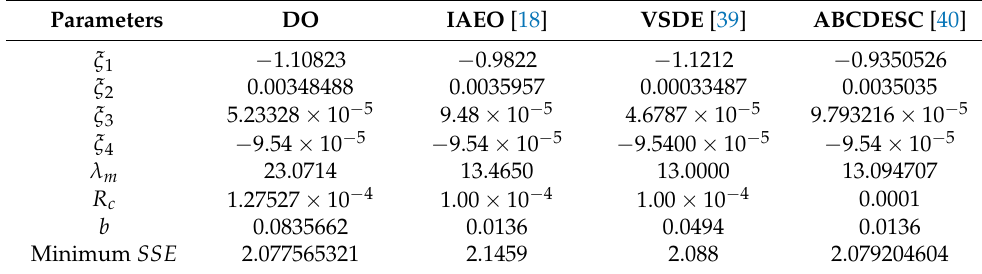
Table 6. Optimum values of unknown parameters and SSE of NedStack PS6.